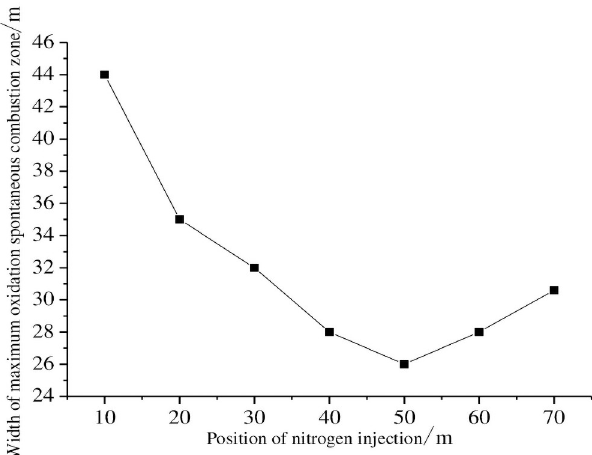
Fig 5. Goaf oxidized zone width with injection nitrogen position